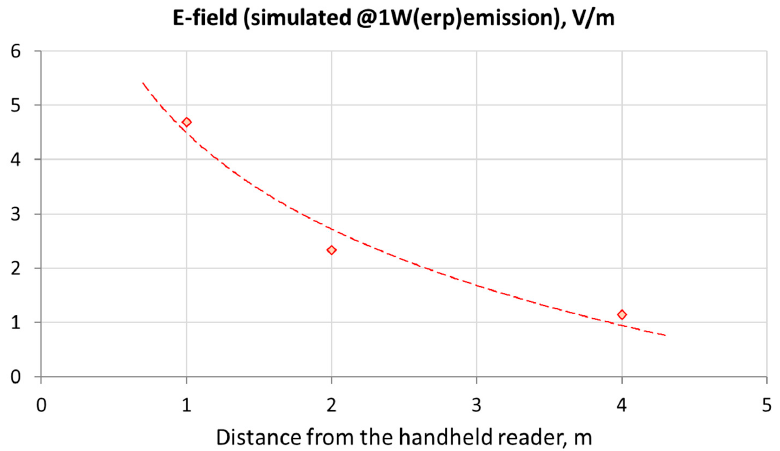
Figure 10. E-field distribution at a plane normal to the UHF-RFID gun antenna plane at a radiated power of 1 W. Spatial distribution of E-field measured near the AS-RFID reader.